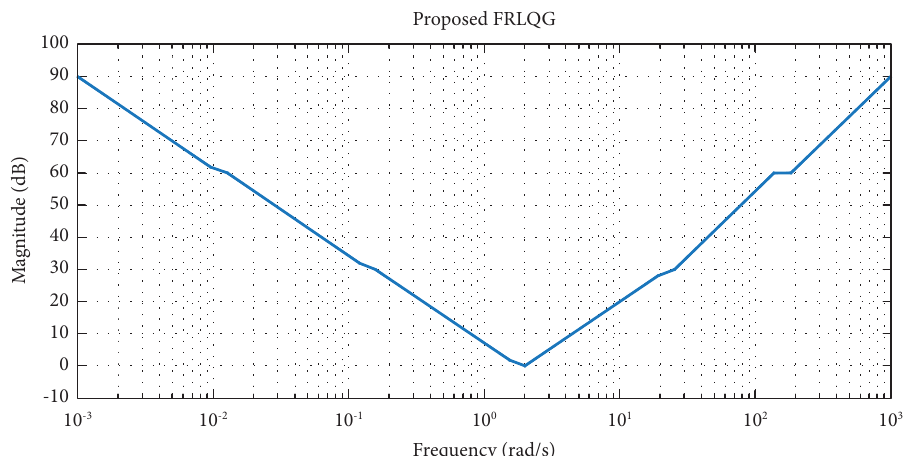
Figure 5: Analysis of the magnitude of the controller.